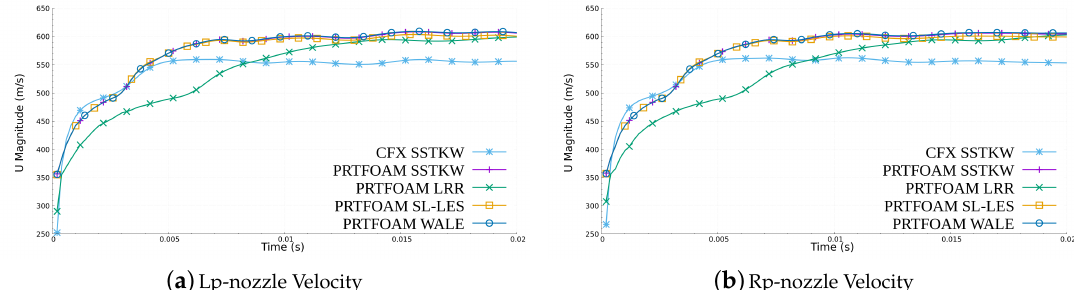
Figure 20. Velocity–time curves of the simulation results of different models at the ( a ) Lp-nozzle and ( b ) Rp-nozzle sampling point. The curves of PRTFOAM SSTKW, PRTFOAM SL-LES, and PRTFOAM WALE basically coincide. The velocity at the nozzle gradually increases with the steam dumping process and finally stabilizes at approximately 600